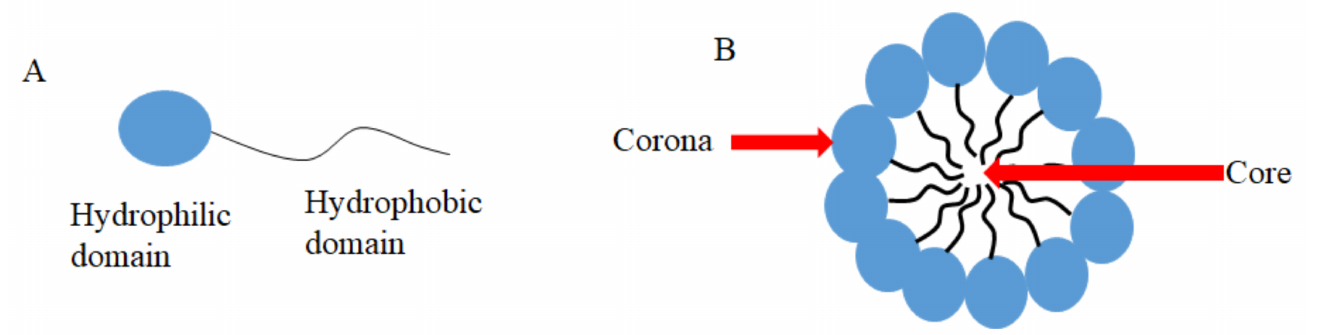
Figure 1. Schematic representation of: ( A ) an amphiphilic molecule and ( B ) an assembled